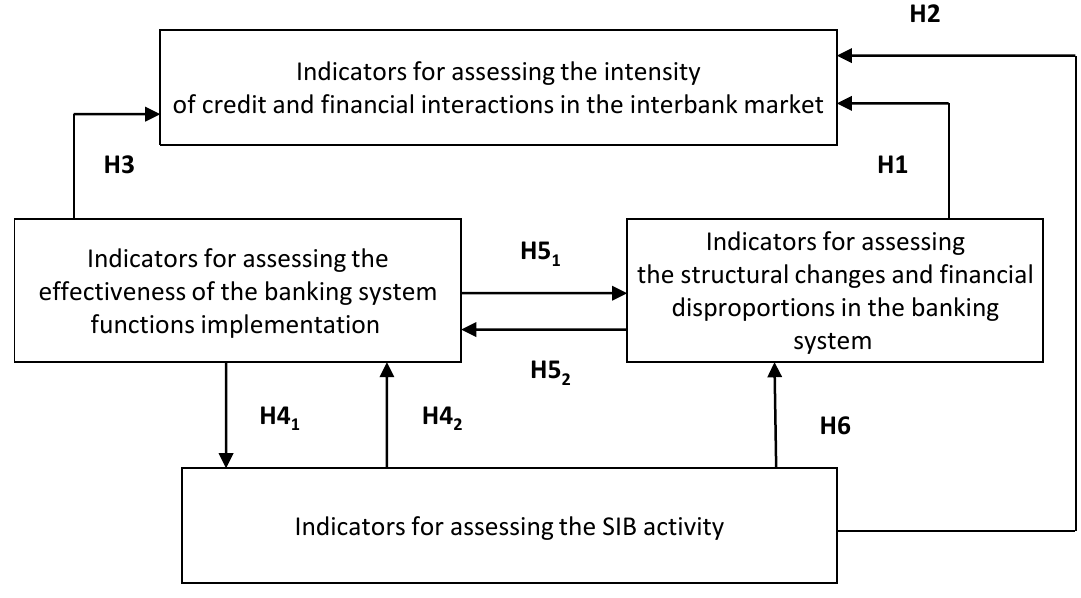
Figure 1. Hypothetically determined causal relationships between indicators for